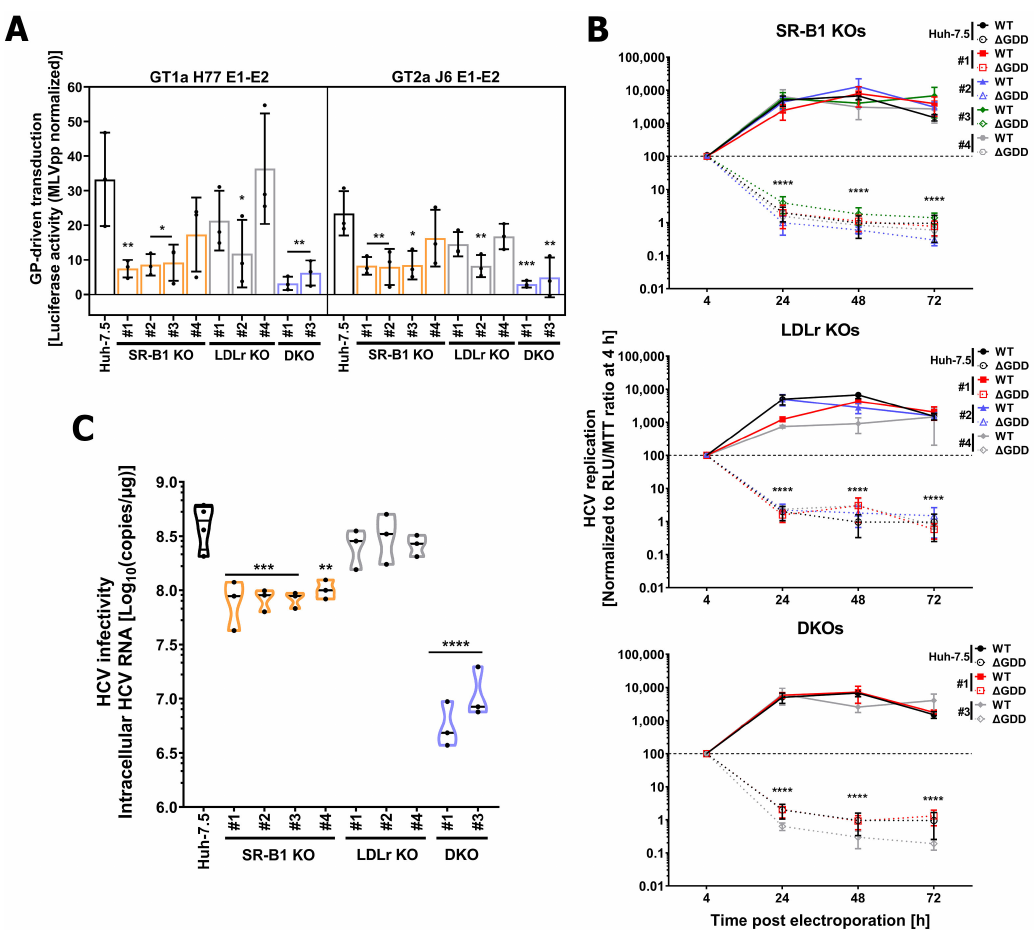
Figure 4. Lipoprotein receptor SR-B1 and LDLr do not affect HCV replication, SR-B1 facilitates GP-driven cell entry, and both redundantly participate in HCV infection. HCV GP-mediated entry in lipoprotein-deficient cells ( A ). Huh-7.5 parental (black bars), SR-B1 (light orange bars), LDLr (grey bars), and DKOs (light blue bars) were transduced with NLuc-encoding GT1a H77 or GT2a J6 HCVpp, negative (NoEnvpp), and positive (MLVpp) controls for 6 h. Six hpt, lentiviral particles were removed and reporter expression measured 72 h after. Raw relative light units (RLU) values were normalized to MLVpp values of the same cell line to account for intercellular variation. NoEnvpp normalized values were subtracted to represent HCV GP-specific entry. HCV subgenomic replication in Huh-7.5 and lipoprotein receptor-deficient cells ( B ). Cells were transfected with a HCV GT2a replication-competent (WT) or deficient ( ∆ GDD) subgenomic genomes tagged with FLuc. RLU values were normalized to 4 h post-electroporation and to MTT values to account for initial RNA delivery and cell growth variabilities between cell lines. Graph represents the average of three independent experiments performed in triplicate +/ − sem. HCVcc infection of lipoprotein-deficient and parental cells ( C ). Indicated cell lines were infected untagged GT2a Jc1 HCVcc. Virus inoculum was removed hpi. Twenty-four hpi cells were lysed and Intracellular HCV RNA copies determined with an X-tail based absolute RT-qPCR. Data are shown as violin plots with median (black line) and individual values (black dots). Data distribution is symbolized by the plots’ shape. A two-way ANOVA with Dunnett post hoc ( α = 0.05, DF = 10) was used for statistical analysis of HCV entry and replication assays and a one-way ANOVA with Sidak’s post hoc for HCVcc infection assay ( α = 0.05, DF = 25). p -value was calculated and shown as: * p ≤ 0.05; ** p ≤ 0.01; *** p ≤ 0.001; **** p ≤